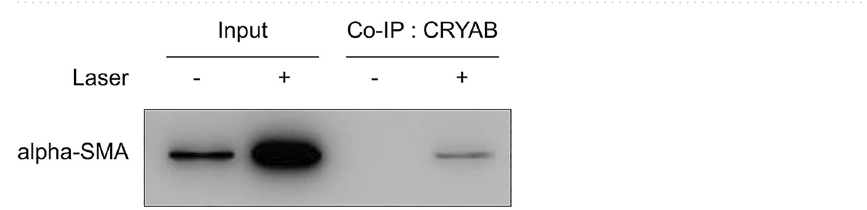
Figure 8. Interaction between crystallin alpha B (CRYAB) and alpha smooth muscle actin (alpha-SMA). Western blot analysis of proteins following the co-immunoprecipitation assay. Laser-exposed mice eye tissue lysates were co-immunoprecipitated with CRYAB. Alpha-SMA was successfully co-immunoprecipitated with CRYAB. Uncropped blot images are presented in supplementary information (Supplementary Fig.